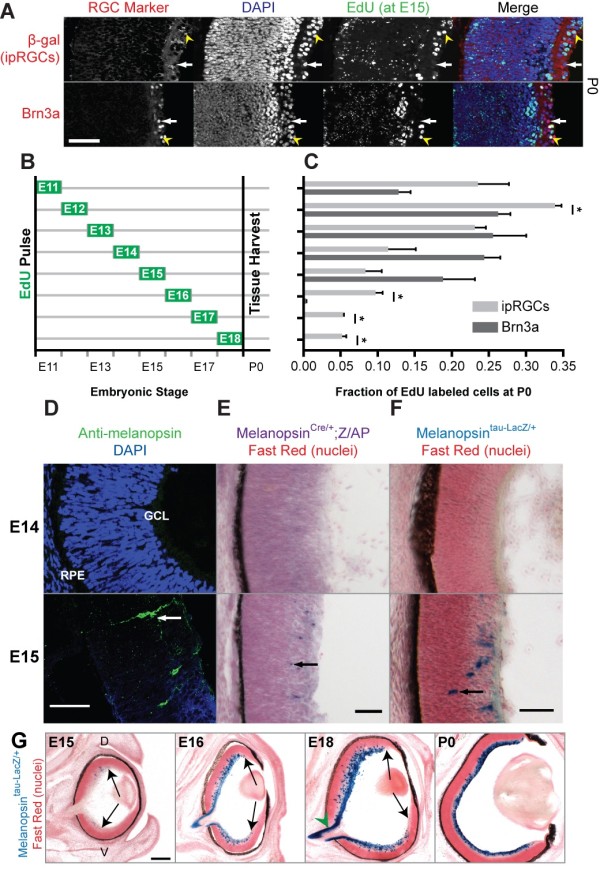
Birth and melanopsin expression of ipRGCs. (A,B) The birthdates of ipRGCs were compared to Brn3a-positive RGCs (representative images in (A), paradigm in (B)). (C) For each time point, we determined the proportion of ipRGCs labeled with EdU; asterisks indicate significant difference between ipRGCs and Brn3a (t-test, P < 0.05). Representative sections with double-labeled RGCs (yellow arrowheads) and EdU-negative RGCs (white arrows) from postnatal day 0 (P0) retinas pulsed with EdU at embryonic day 15 (E15) are shown in (A). Note that the ipRGC marker beta-galactosidase (β-gal), is cytoplasmic, while Brn3a and EdU are nuclear. For all EdU time points, n = 3 to 4 retinas per time point, mean ± standard error of the mean. (D-F) Melanopsin (Opn4) expression begins at E15 based on immunofluorescence (D), and the MelanopsinCre/+;Z/AP (E) and MelanopsintauLacZ/+ genetic labeling methods (F). The MelanopsinCre/+;Z/AP labels all ipRGC subtypes and does not depend on the melanopsin locus for signal strength. Arrows in D-F denote migrating cells. GCL; Ganglion Cell Layer and RPE; Retinal Pigmented Epithelium. (G) Coronal sections from MelanopsintauLacZ/+ mice show an initial lack of ipRGCs in the periphery at E15, which is entirely filled in by P0 (arrows; D, dorsal; V, ventral). Note the lack of X-gal staining within the central optic nerve at E18 (G, green arrowhead). Scale bars: 50 μm (A,D-F); 100 μm (G).